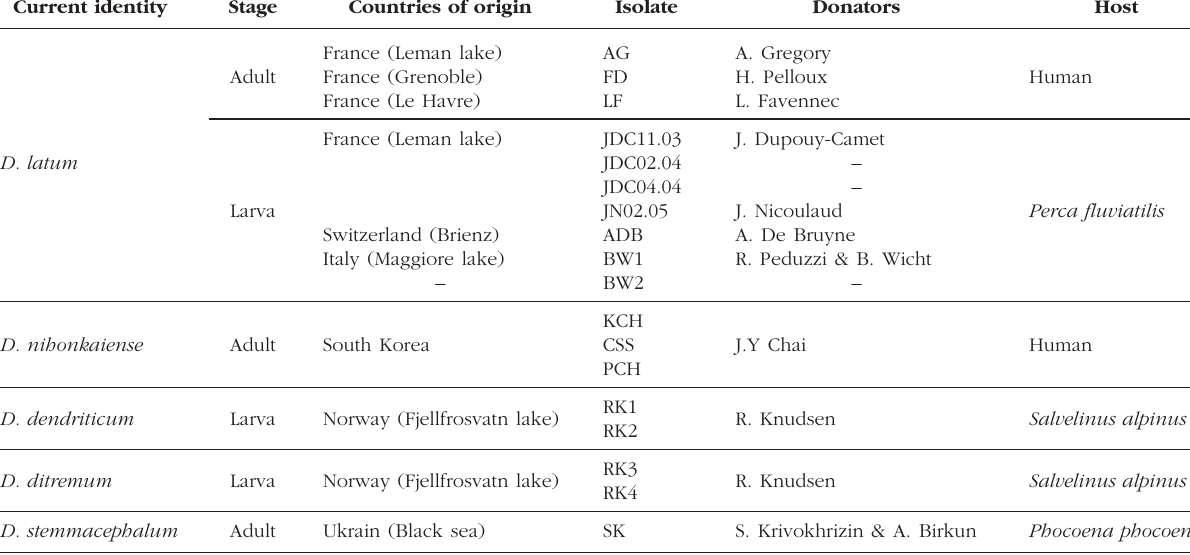
Table I. – Characteristics of the Diphyllobothrium